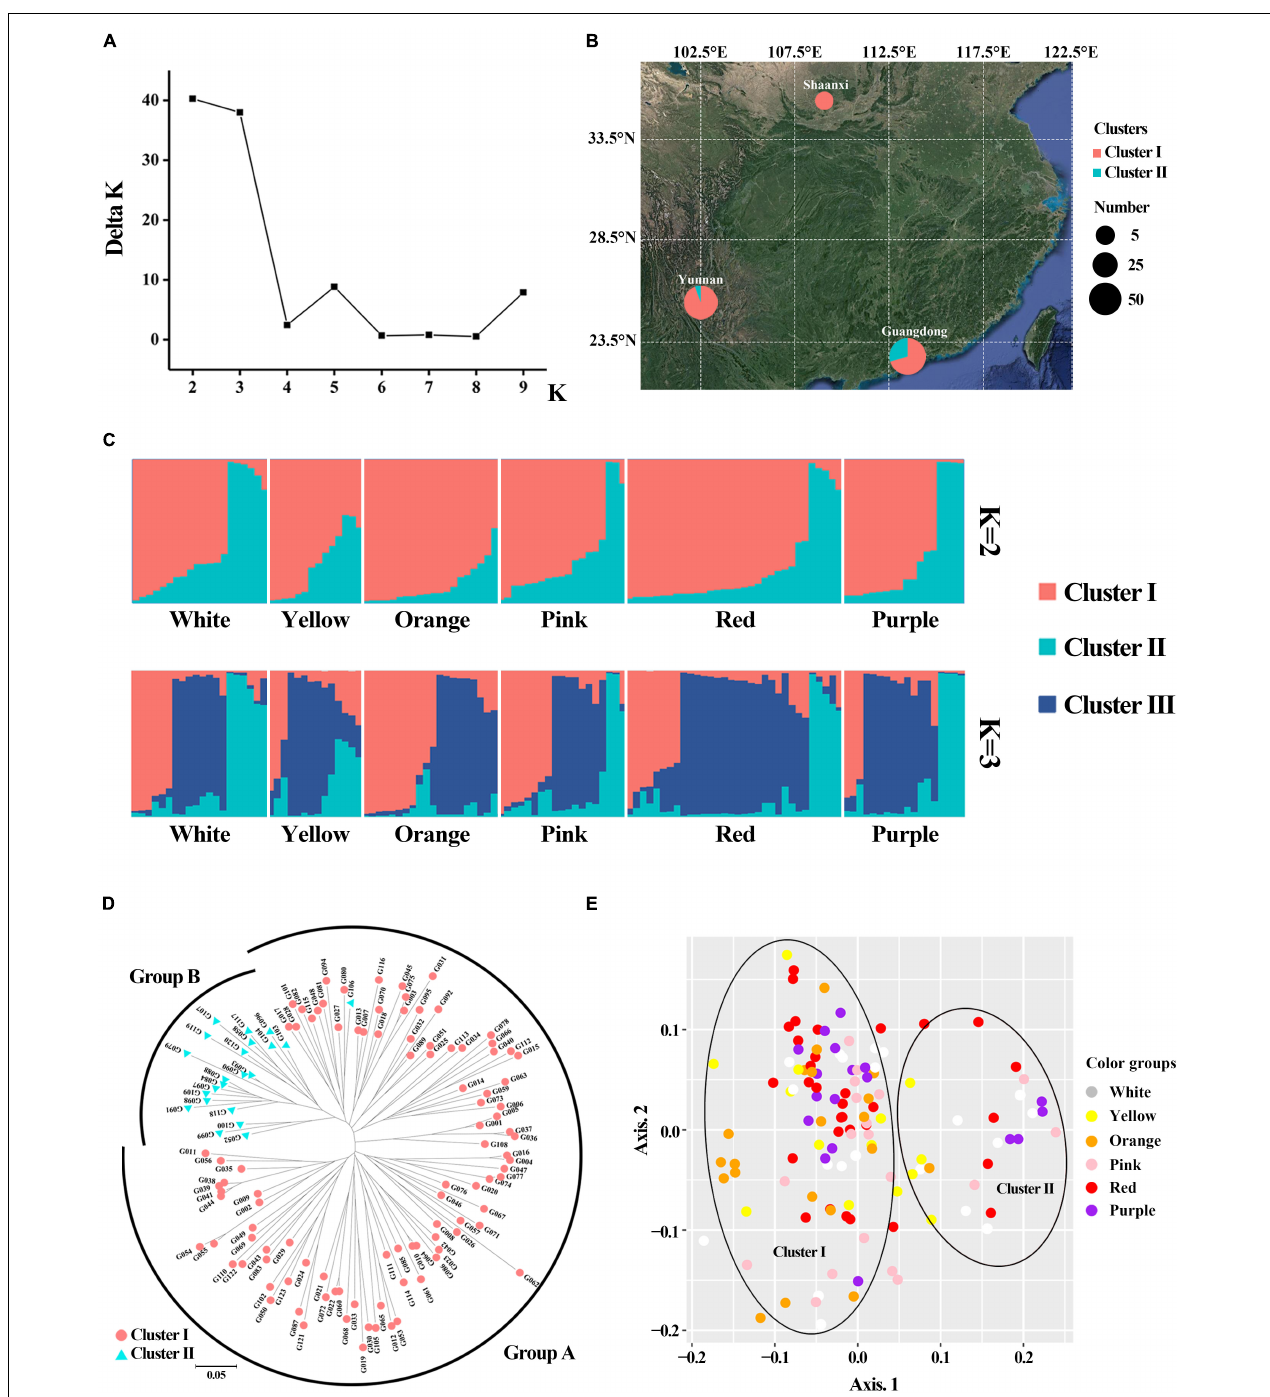
FIGURE 7 | Genetic structure and cluster analysis for 123 gerbera accessions based on 48 EST-SSR. (A) The value of (cid:49) K and K in populations structure analysis. (B) Grouping of populations according to structure ( K = 2) and their geographical source. (C) Population structure analysis ( K = 2 and 3). (D) Neighbor-joining tree. (E) Principal coordinate